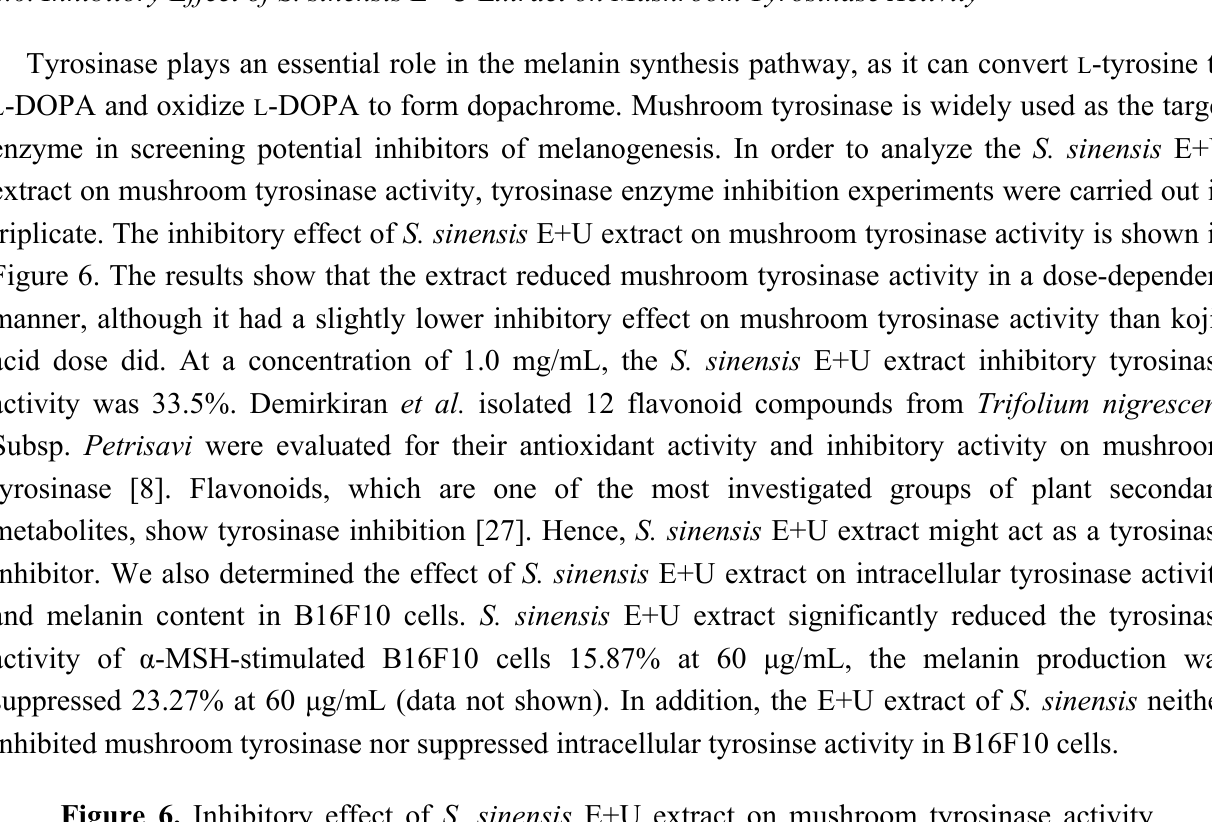
Figure 6. Inhibitory effect of S. sinensis E+U extract on mushroom tyrosinase activity. Different concentrations of the extract or kojic acid (0.05, 0.1, 0.2, 0.4, 0.8 and 1.0 mg/mL) were incubated with the same units of mushroom tyrosinase. Results are presented as mean ± SD for the three separate